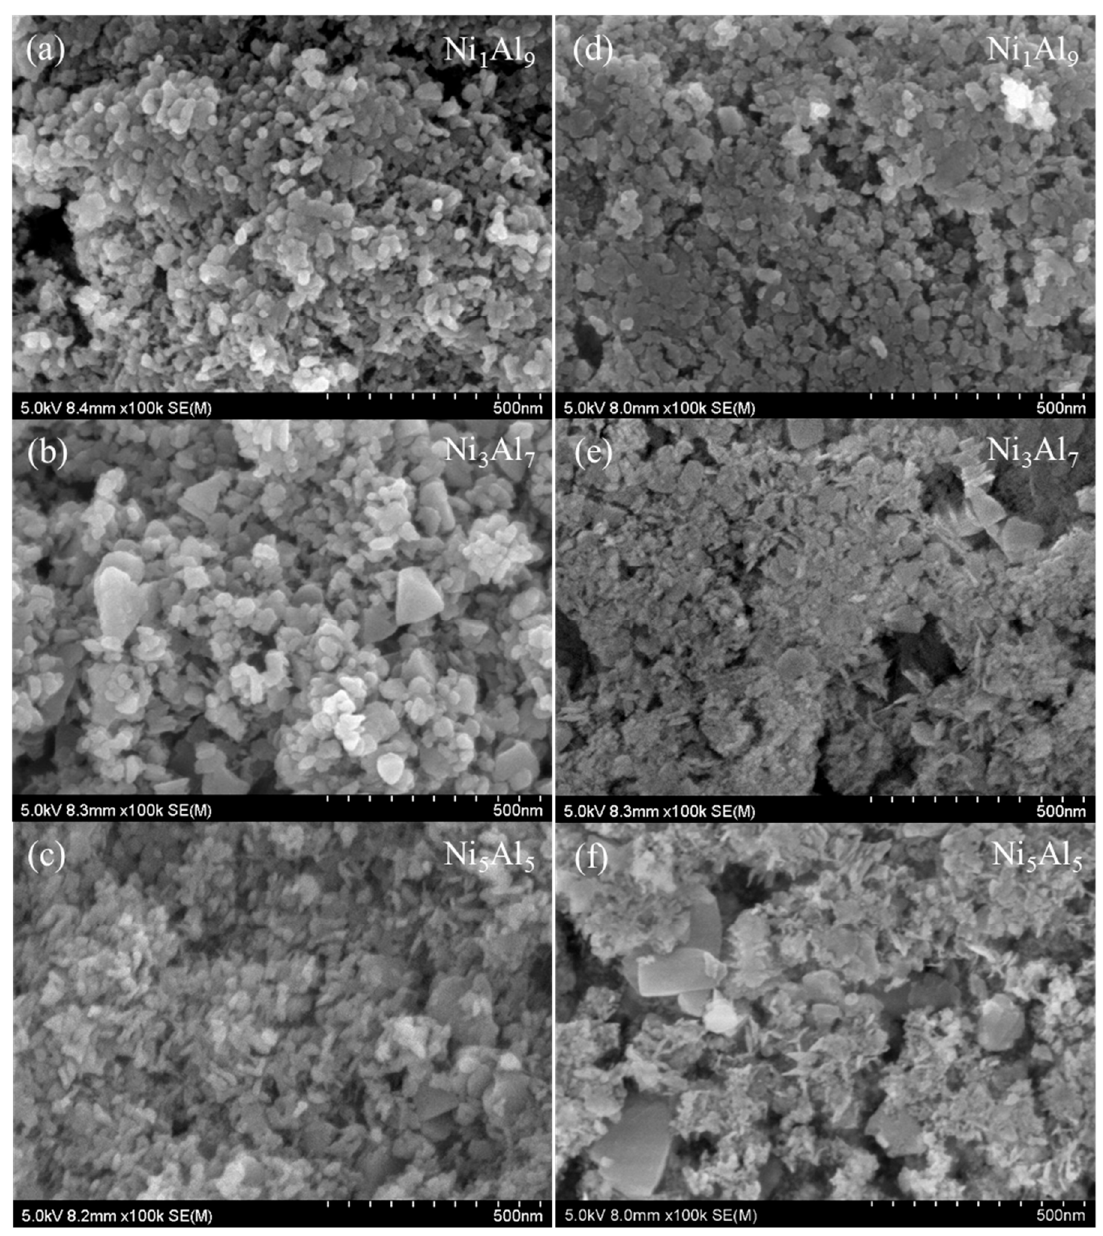
Figure 2. Scanning electron micrographs of the NiAl 2 O 4 catalysts with various Ni/Al ratios: ( a – c ) calcined catalysts and ( d – f ) reduced catalysts.